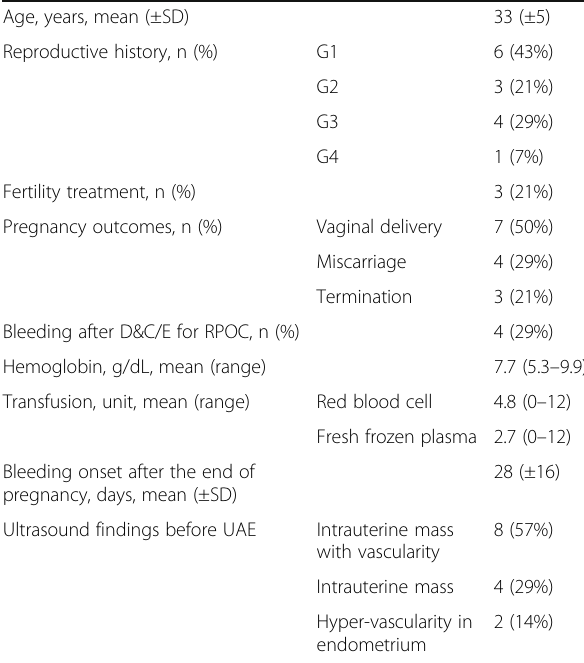
Table 1 Patients characteristics ( n =